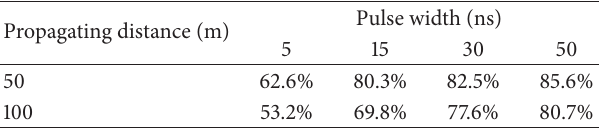
Table 4: Measurement value of signal peak power transmittance for different pulse